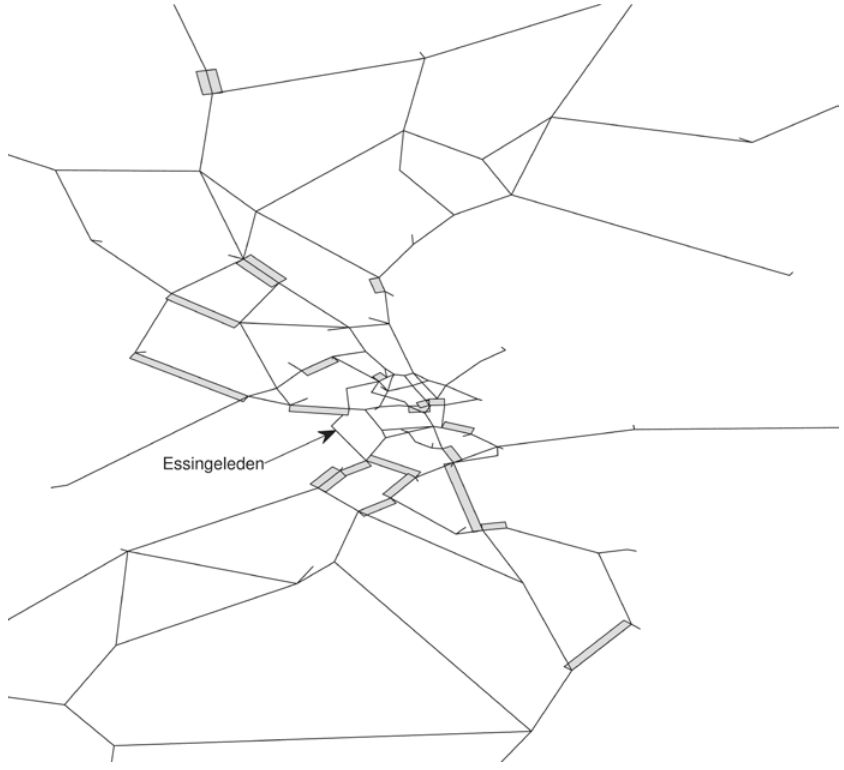
Figure 5. Best obtained toll location solution for 24 located tolls. Tolled links are marked with a grey